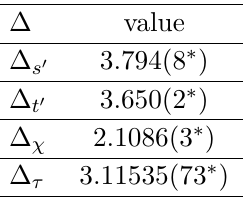
Table 4 . Conformal bootstrap predictions for subleading scalar operators using the extremal functional method. The superscript (cid:3) means that the error bar is estimated based on the extremal functional